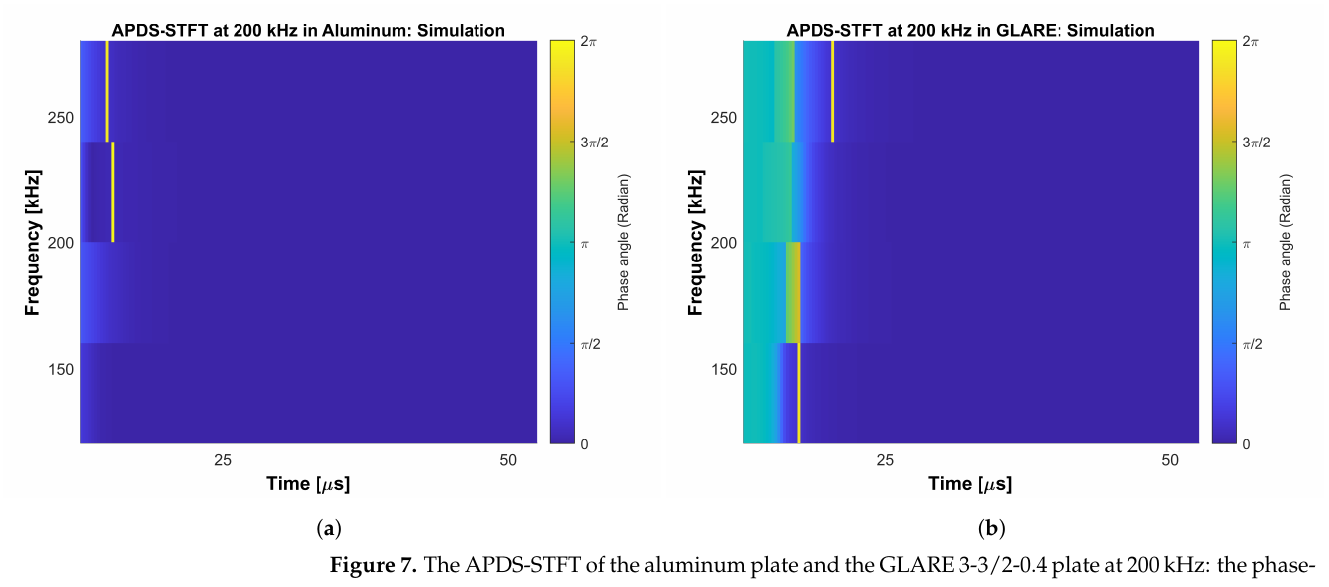
Figure 7. The APDS-STFT of the aluminum plate and the GLARE 3-3/2-0.4 plate at 200kHz: the phase- shift in S 0 -mode is identified whereas the rest of the spectra shows no phase shift in correspondence with the time signals. ( a ) APDS-STFT of the Aluminum plate at 200kHz. ( b ) APDS-STFT of the GLARE 3-3/2-0.4 plate at